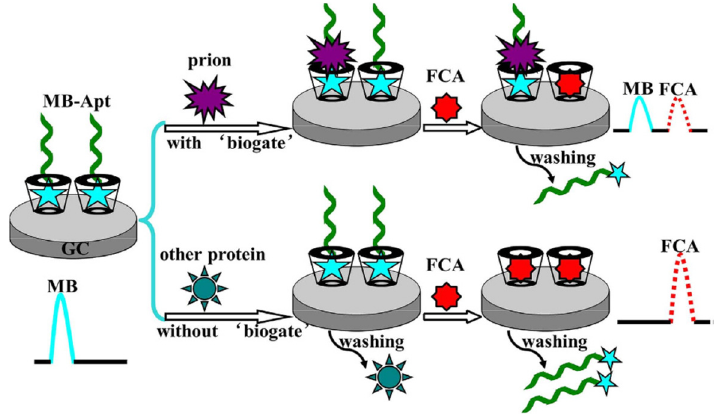
Figure 6. Schematic illustration of the voltammetric aptasensor for prion protein detection. Reprinted with permission from Ref. [142].